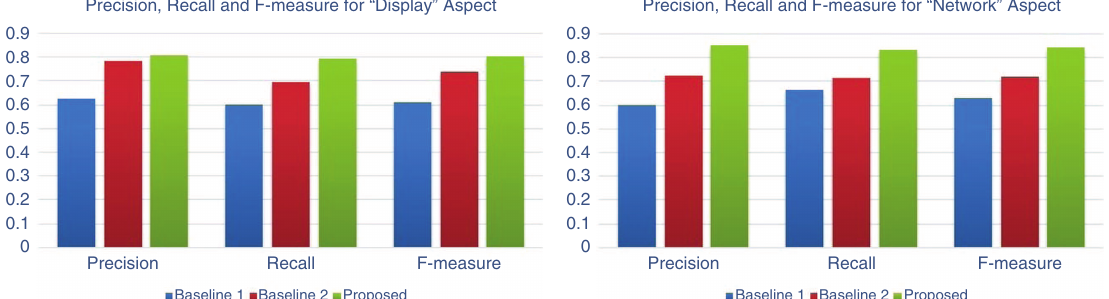
Figure 5: Graph Showing Precision, Recall, and f-Measure for Various Aspects.